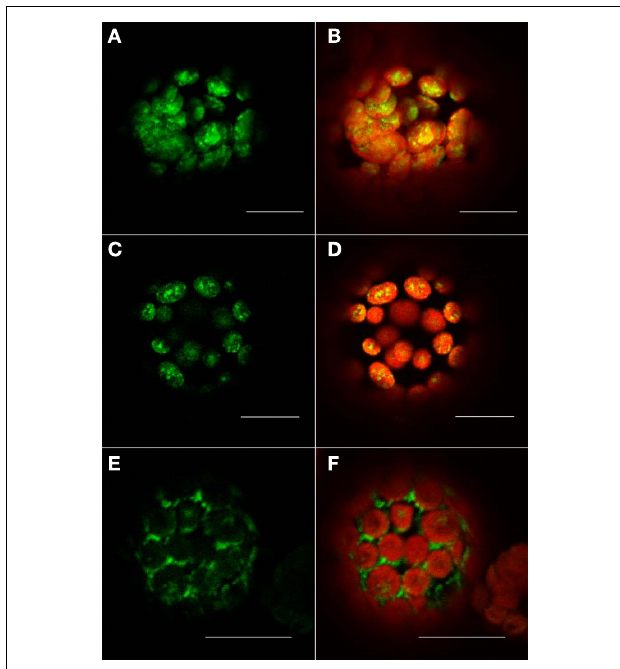
FIGURE 6 | Fluorescent microscopy analysis of tobacco protoplast cells transformed withAt5g19540–GFP construct. Protoplast cells transformed with control for the plastid –TP101(GFP) (A,B) , At5g19540 with C-terminally fused GFP (C,D) , and At5g19540 with N-terminally fused GFP (E,F) . Left panel – GFP (green fluorescence), right panel – channels overlay plus chlorophyll (red) autofluorescence. Bars in all pictures are 15 μ